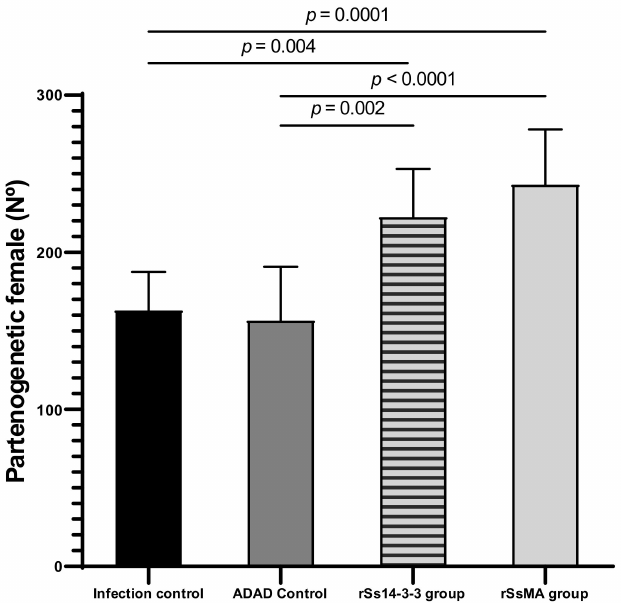
Figure 3. Number of S. venezuelensis parthenogenetic females after immunization with rSs14-3-3 and rSsMA formulated in ADAD vaccination system and challenged with 3000 L3. Bars represent means ± SEM. The number of recovered females under each experimental condition was evaluated by one-way ANOVA analysis with respect to the infection control group (F (3,27) = 1; p < 0.0001). Post-hoc Tukey’s honestly significant difference (HSD) test p -values are shown in the